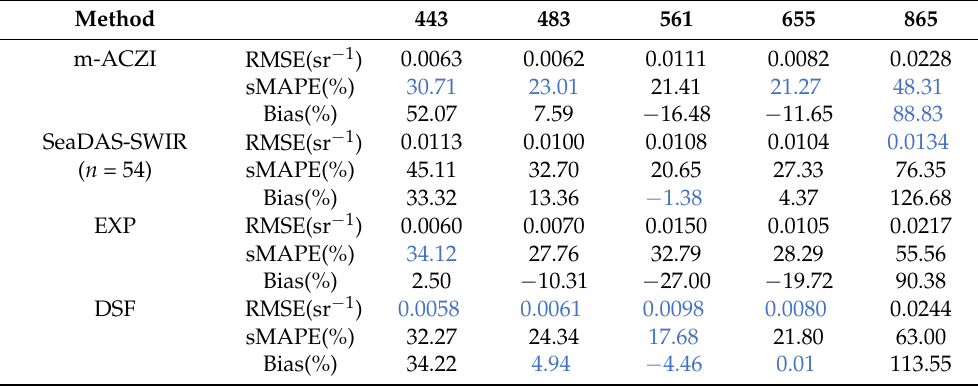
Table 2. Statistics of the accuracy measures for the m-ACZI, SeaDAS, DSF, and EXP algorithms using in situ R rs measurements. The BLUE number represents the minimal statistical